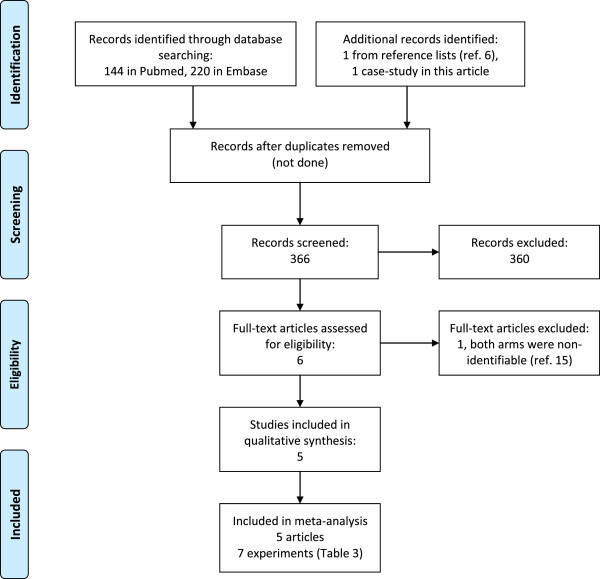
PRISMA flow diagram.